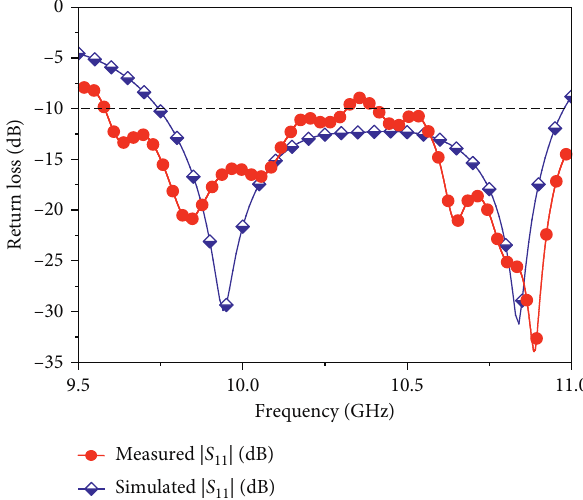
Figure 5: Tested and simulated return loss (dB) across the operable frequency